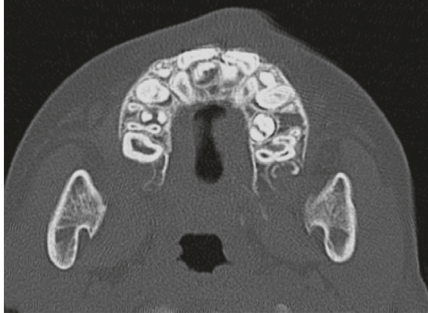
Figure 8: TC dentascan of upper